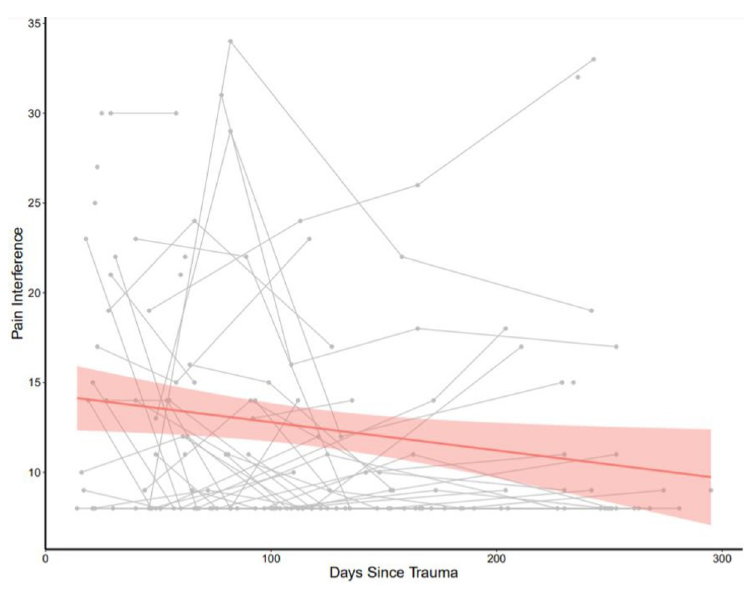
tion at a 1-year follow-up [71]. A study of individuals with rheumatoid arthritis (n = 95) found